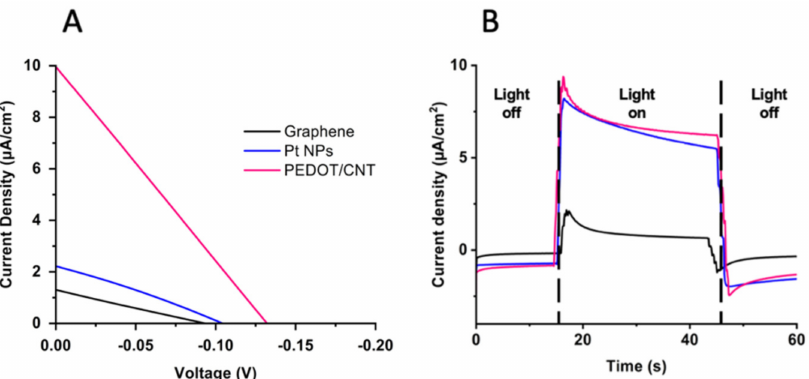
Figure 6. Design and performance of PSI-sensitized solar cells (PSI–SSC) with variable counter electrodes. ( A ) White light illuminated current density-voltage ( J V) curves of the three PSI-SSCs. ( B ) Representative chronoamperometry curves of the three PSI-SSCs illuminated with white light. Table 3. PSI-sensitized solar cells (PSI-SSC) performance using different counter electrodes and a liquid-based aqueous Co II/III electrolyte. V OC (mV) J SC ( µ A/cm 2 ) FF % PCE % PEDOT/CNTs −